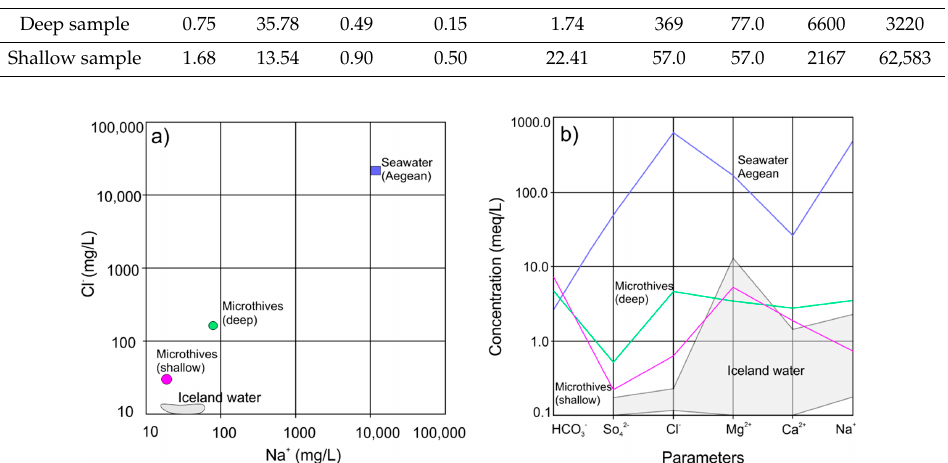
Table 3. Ionic ratios of water samples from the region of Microthives (mg/L) [28]. Ionic Ratio Mg / Ca Na / K Na / Cl